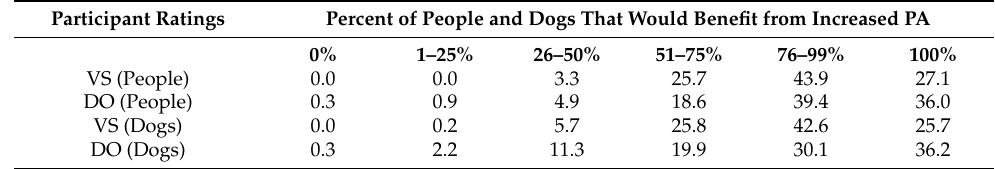
Table 2. Dog owner (DO; n = 1028) and veterinary staff (VS; n = 631) ratings of the percent of people and dogs that would benefit from increased PA.